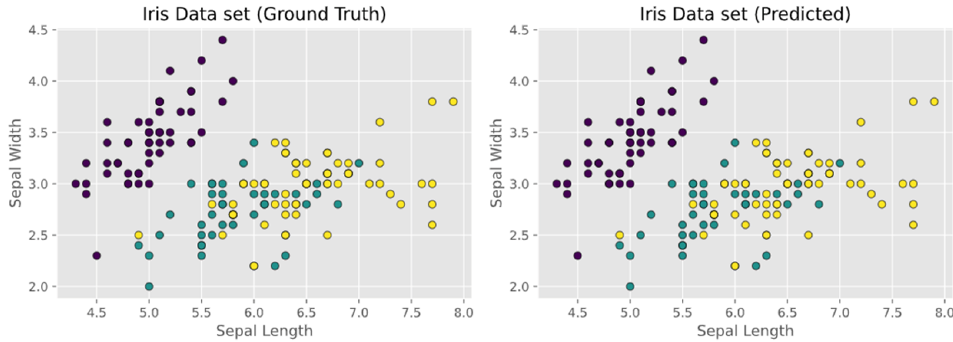
Figure 15. Ground truth vs. predicted labels from FNN-PSO algorithm on Iris.